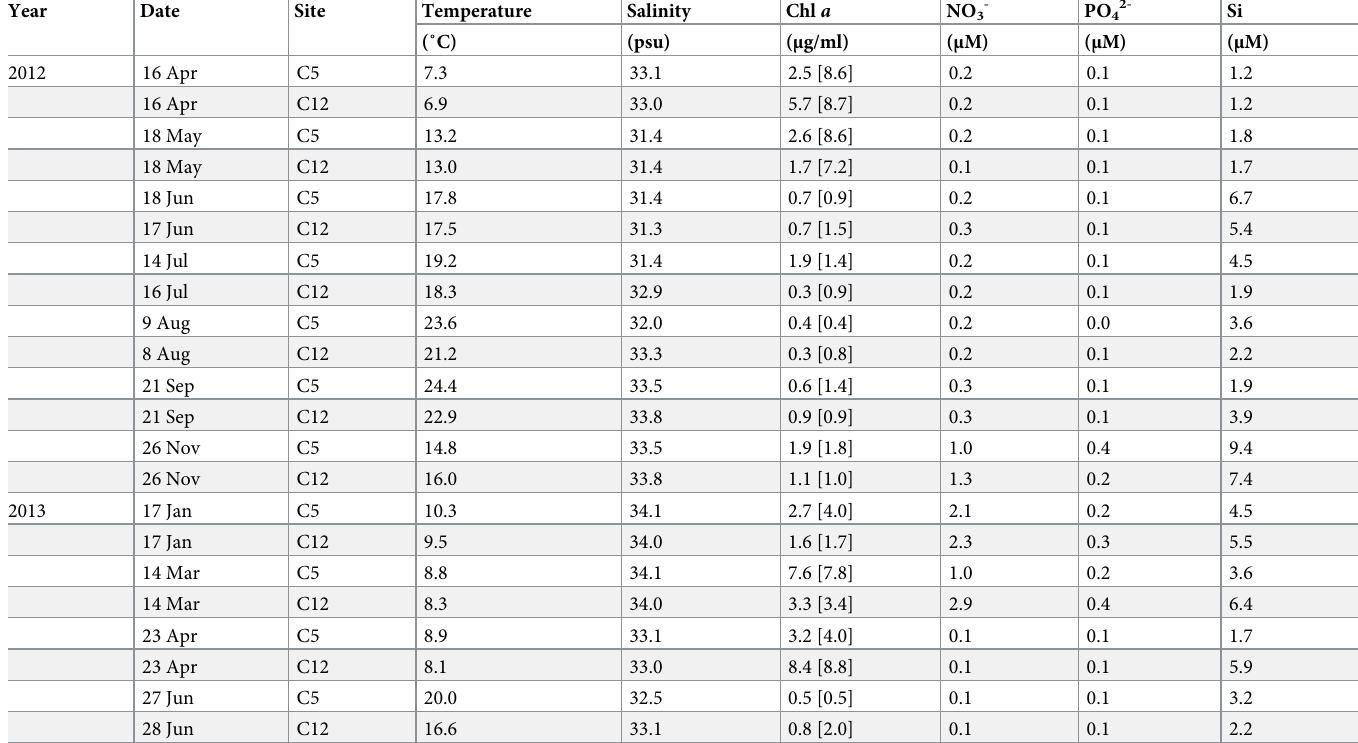
Table 1. Sampling dates and environmental variables. The environmental variables were measured in surface water ( � 1-m depth); only the values in square brackets were measured in the sub-surface chlorophyll a maximum (10- to 50-m